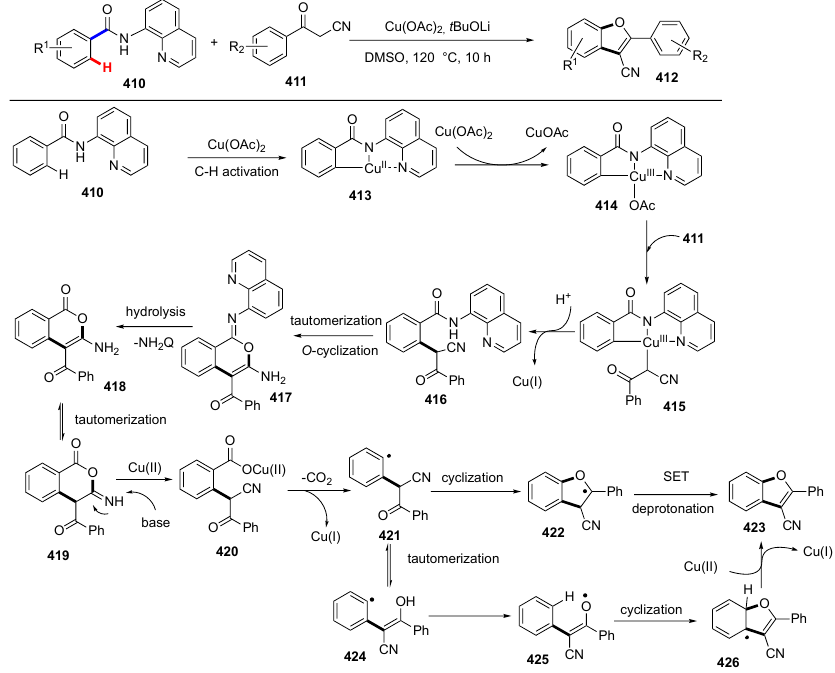
Molecules 2020 , 25 , x FOR PEER REVIEW Scheme 54. Cu-mediated synthesis of 2-aryl-3-cyanobenzofuranes. Scheme 54. Cu-mediated synthesis of 2-aryl-3-cyanobenzofuranes.